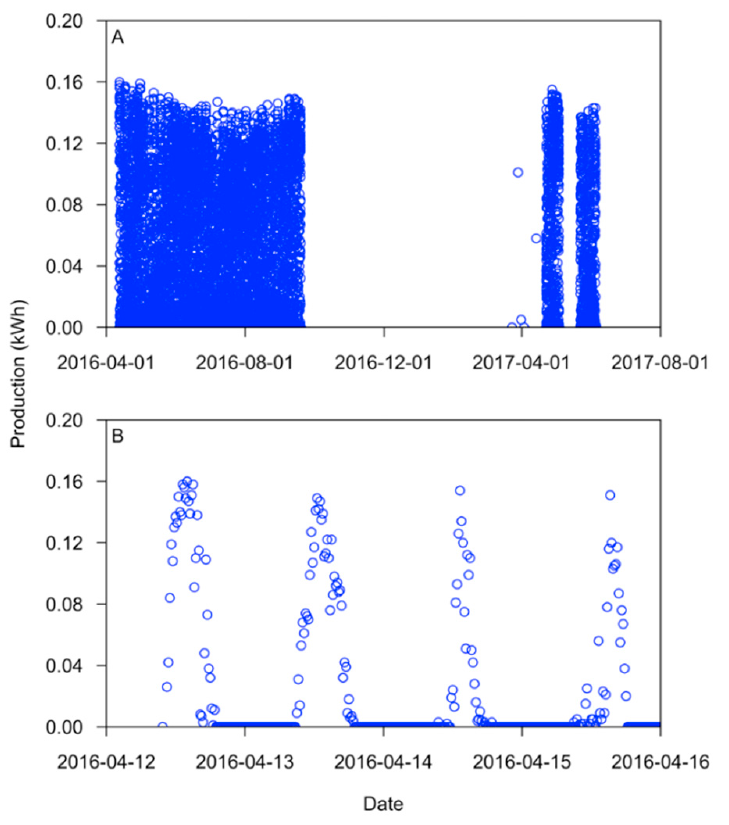
Figure 4. Example of a time-series of electricity production analysed in this study. ( A ) Complete time-series, and ( B ) an excerpt from this time-series showing the first four days of electricity production. Time-series for two short periods of five weeks with contrasting weather conditions were analysed, and anomaly detection was performed on the last week of these two periods. Specifically,